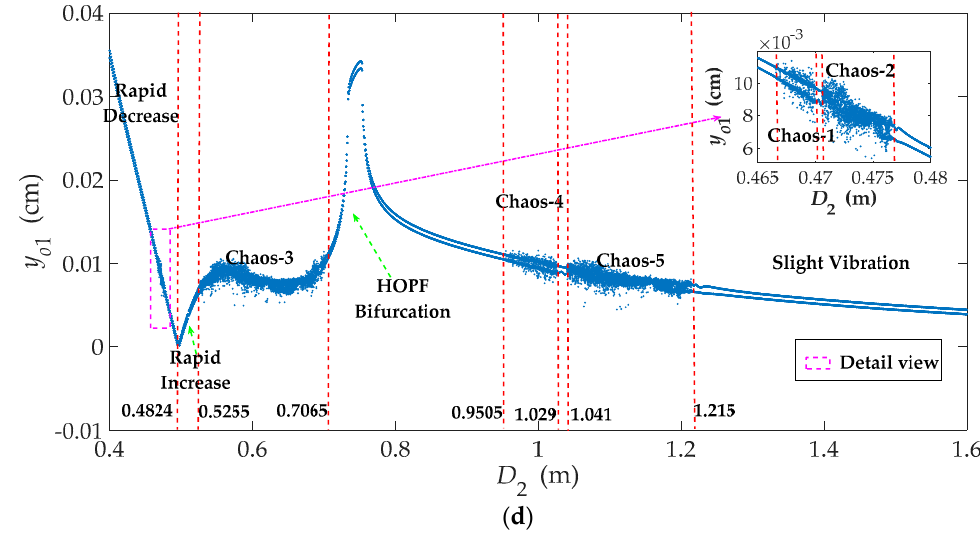
Figure 7. Bifurcation diagrams of the hydraulic unbalance forces ( P x and P y ) and the axis coordinates ( x o 1 and y o 1 ) with the blade exit diameter ( D 2 ) increasing from 0.4 m to 1.6 m. ( a ) Hydraulic unbalance force P x ; ( b ) Hydraulic unbalance force P y ; ( c ) Axis coordinate x o 1 ; ( d ) Axis coordinate y o 1 .